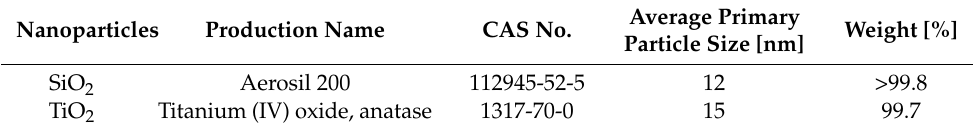
Table 1. Basic properties of SiO 2 and TiO 2